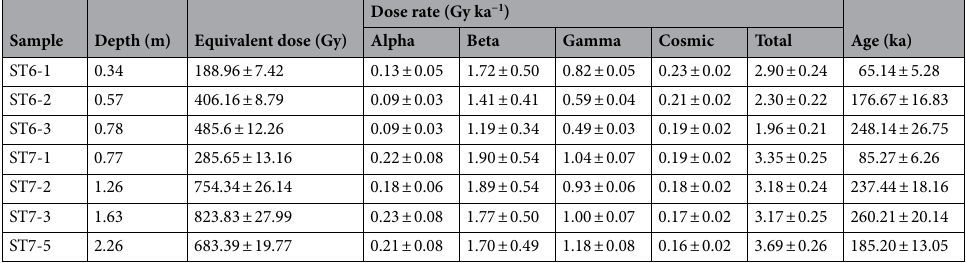
Table 1. Luminescence dating summary. All calculations made prior to rounding. For further data and details relating to the dating, see Methods and SI.